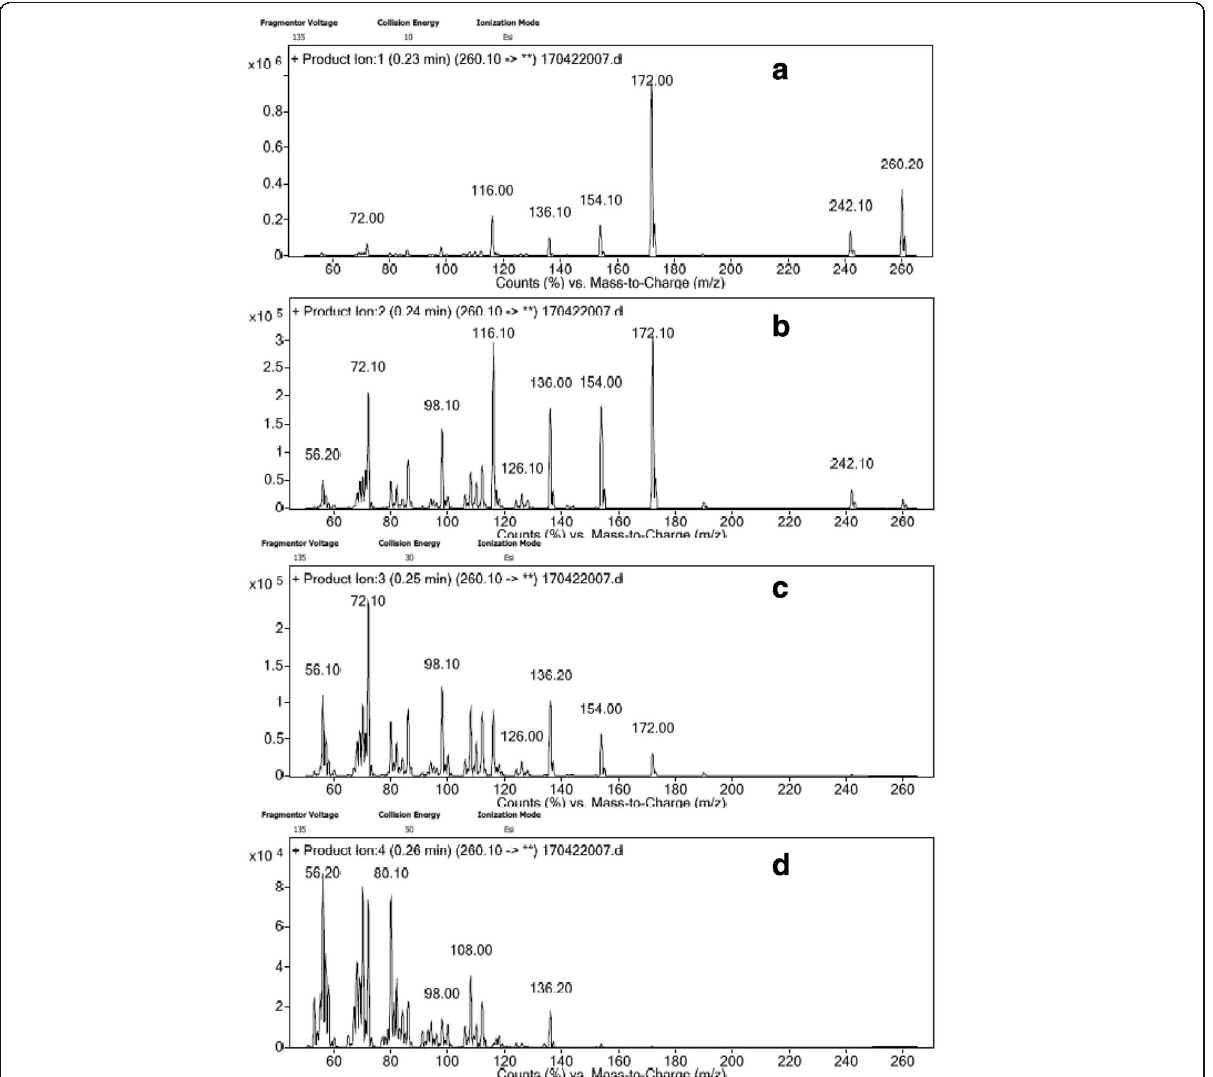
Fig. 8 MS/MS of celgosivir at a 10 eV collision energy, b 20 eV collision energy, c 30 eV collision energy, and d 50 eV collision